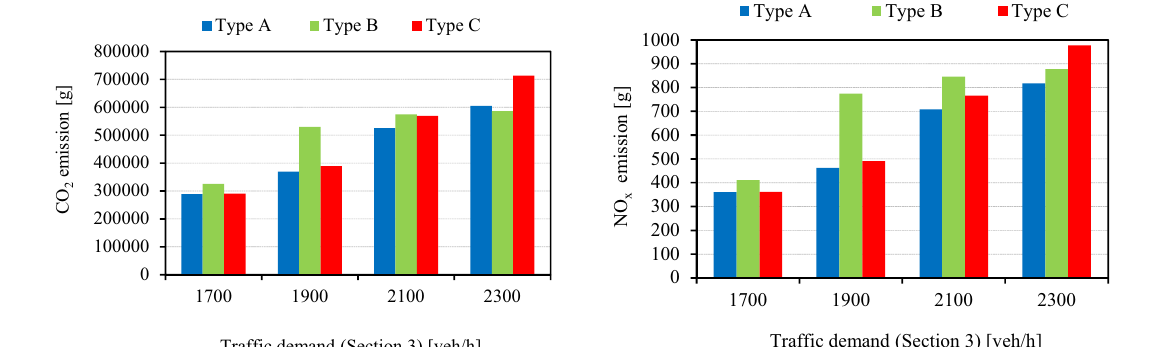
Fig. 12 CO 2 and NO x emissions in function of the traffic demand in Sect. 3 (cfr. Fig. 7)